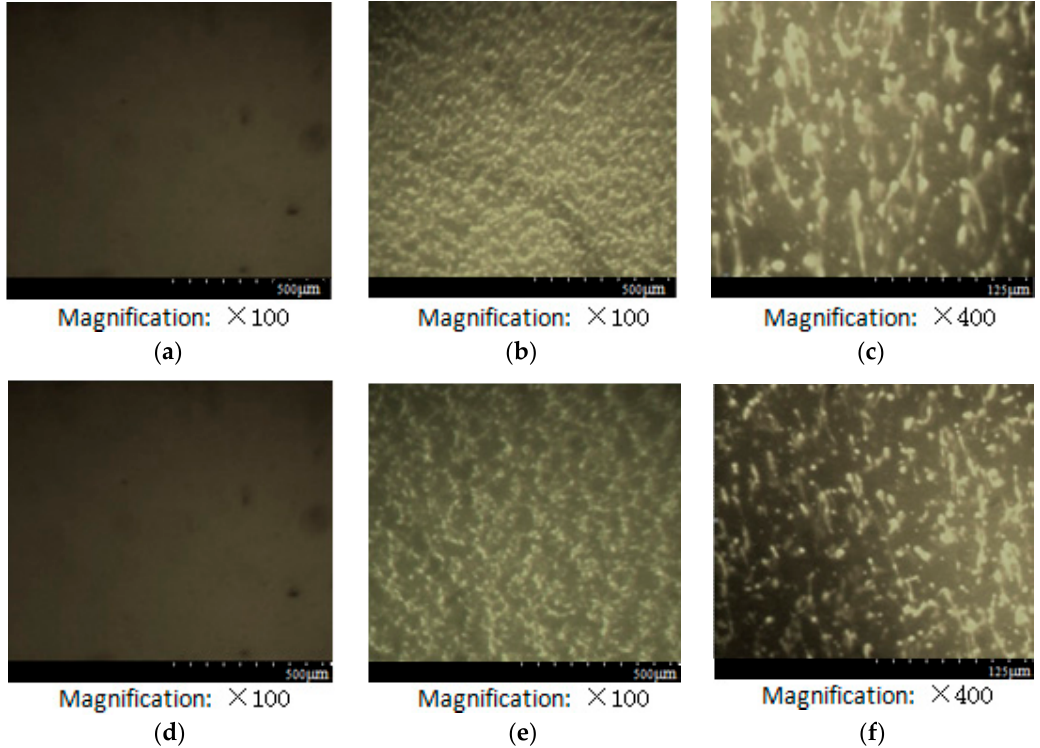
Figure 11. Fluorescence microscope test (stabilizer was S:TMTD:ZnO:BHT:Al 2 O 3 ·2SiO 2 ·2H 2 O = 60:16:4:20:1250). ( a ) Base bitumen; ( b ) top portions (SBS bitumen); ( c ) top portions (SBS bitumen); ( d ) base bitumen; ( e ) bottom portions (SBS bitumen); ( f ) bottom portions (SBS bitumen).